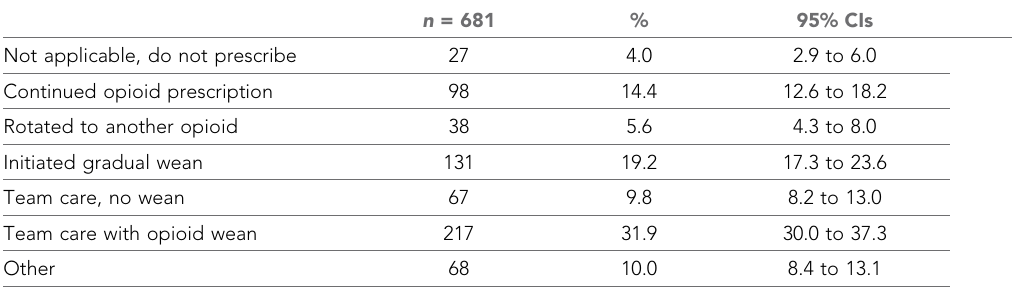
Table 3. Most recent approach with CNCP patient on long-term